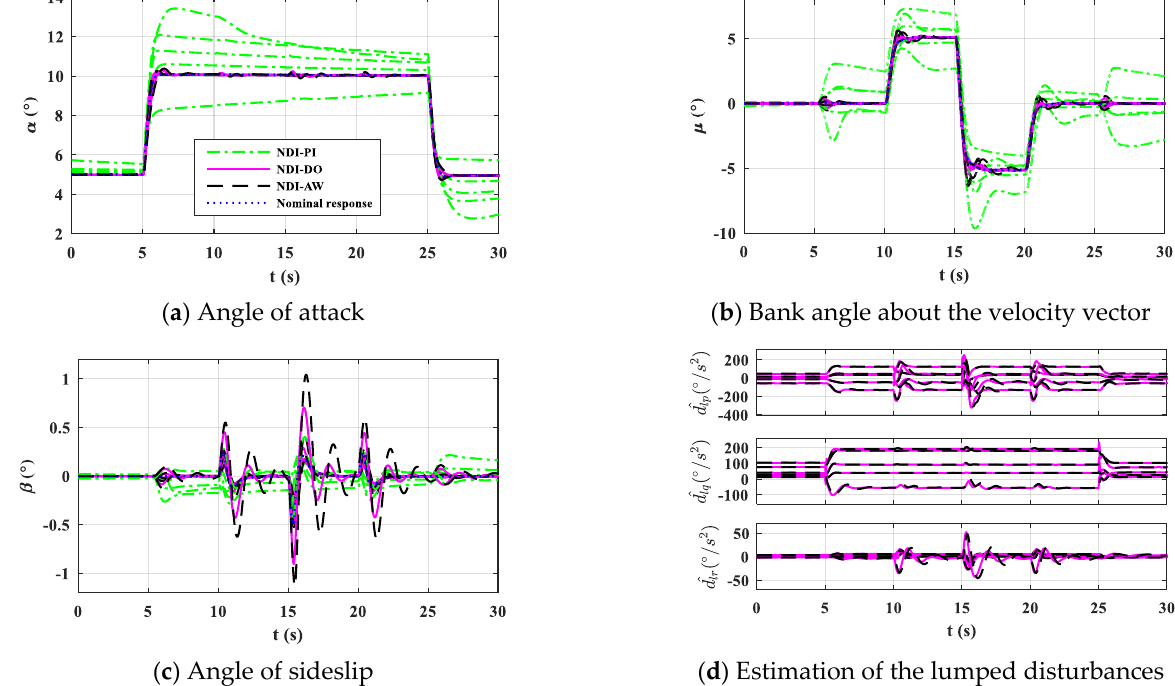
Figure 8. Response of the tailless aircraft model controlled using NDI-PI, NDI-DO, and NDI-AW with the aerodynamic bias and the center of gravity (CG) mismatch.